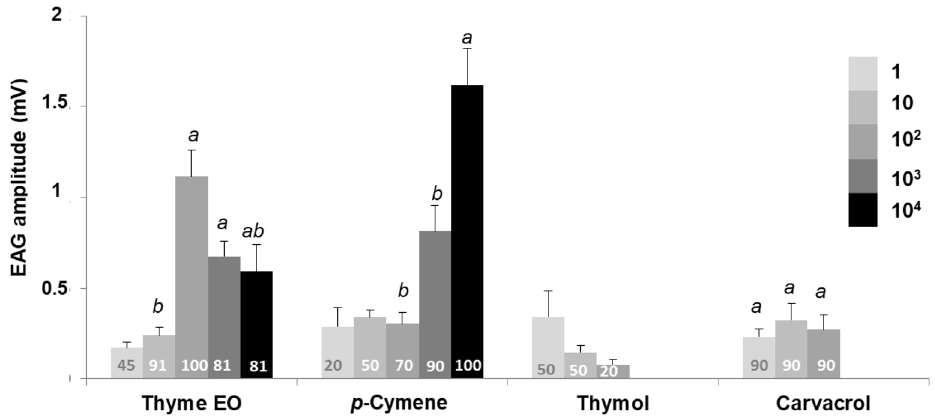
Figure 1. Mean electroantennographic response (mV + SEM) of G. molesta males (n = 10–11) to five different doses (1–10 4 µg) of thyme oil, p -cymene, thymol and carvacrol. The number within each column indicates the percentage of antennae responding to the stimulus, that is, those which showed a net EAG response after subtraction of the solvent response. Columns lacking lower case letters indicate that less than 60% of tested antennae responded to the stimulus. Different letters within each treatment denote significant differences among doses (Kruskal–Wallis test followed by Mann–Whitney U test with Bonferroni